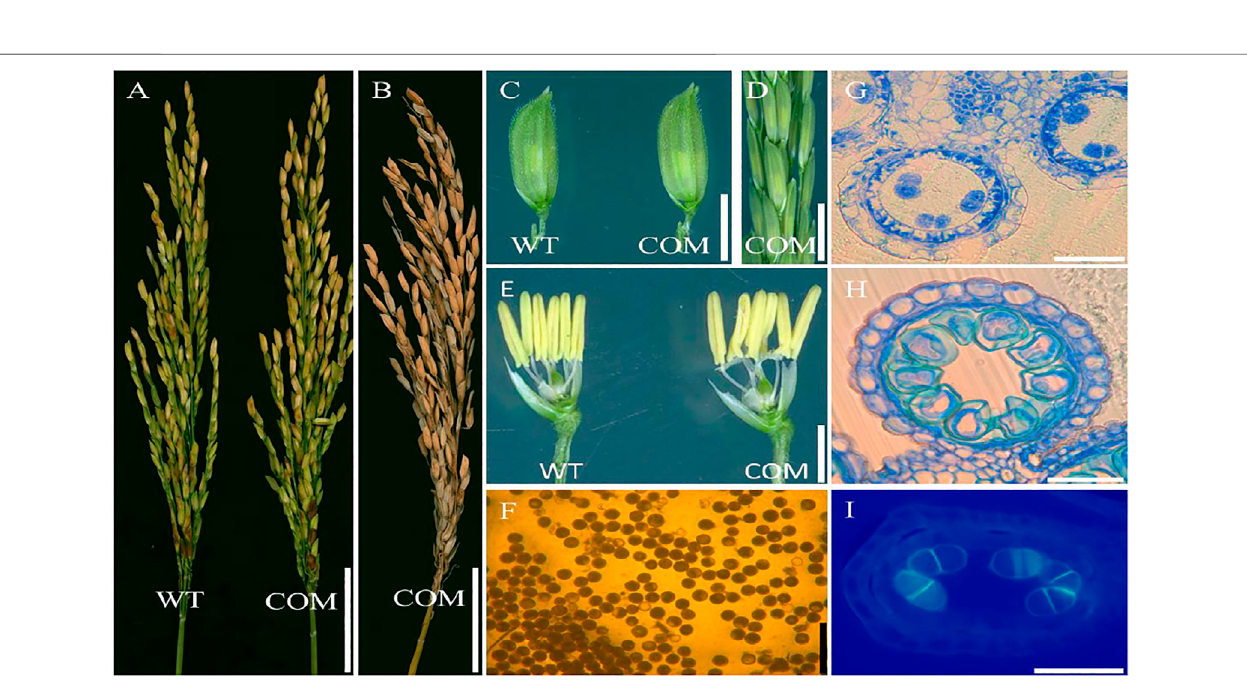
FIGURE12| Phenotypiccharacterizationofthecomplementedline(COM)of DCET1 andwild-type(WT).PaniclesofWTandCOMlineatphysiologicalmaturity (A) . COMlinepanicleatharvestmaturity (B) .SpikeletsoftheWTandCOMline (C) .COMlinepanicleatstage13 (D) .SpikeletsofWTandCOMlineaftertheremovalofpalea andlemma (E) .PollengrainsofCOMlineafterstainingwith1.2%I2-KIstainingsolution (F) .AnthersectionoftheCOMlineatstage8band10,respectively, (G,H) .Aniline blue staining of the anther section at stage 8b (I) . Scale bars (cid:1) 1 cm in (A,B) , 2 mm in (C,D) , 1 mm in (E) , 100 µm in (F), and 15 µm in (G – I)